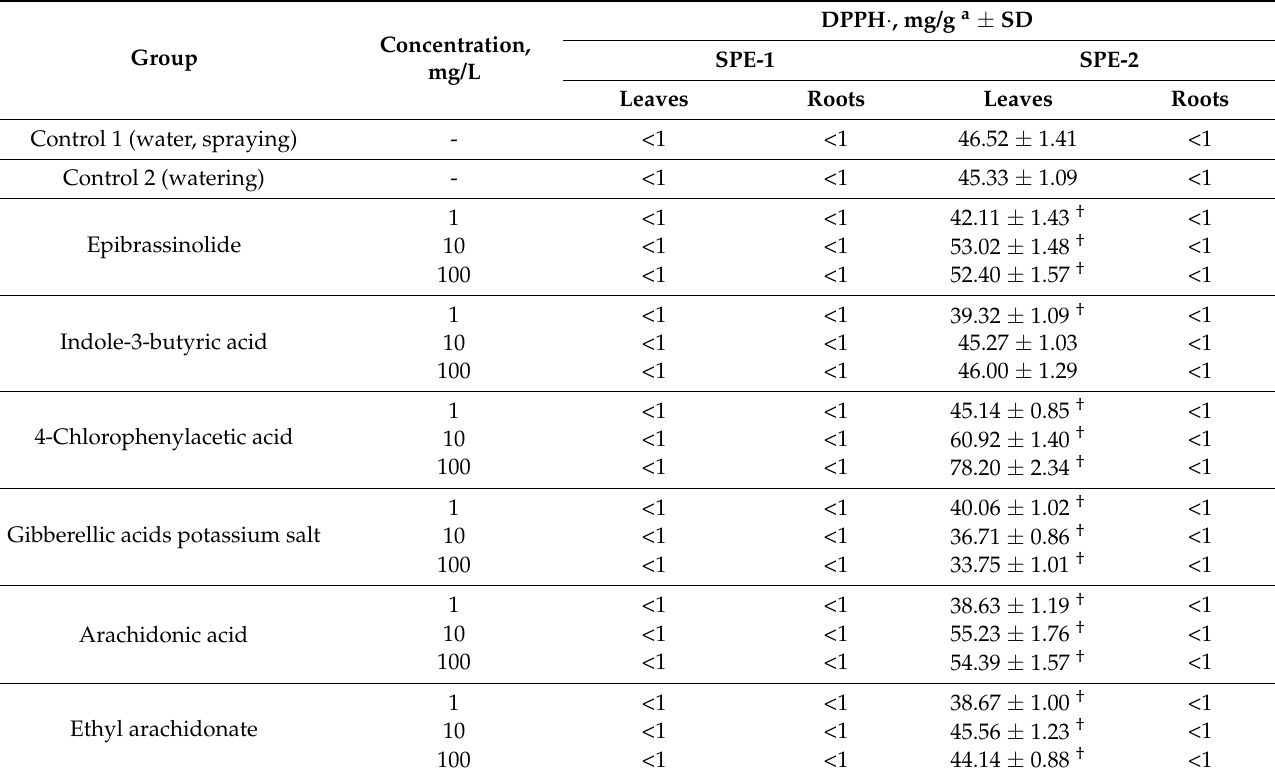
Table 3. DPPH · free radical inhibiting activity of S. repens SPE fractions.